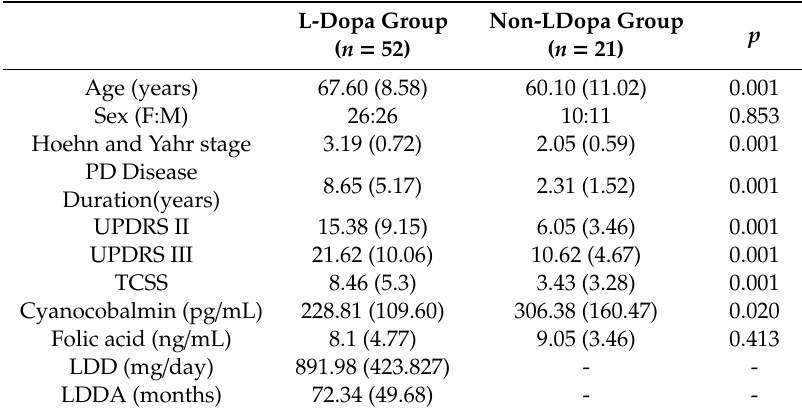
Table 1. Demographic, clinical, and biological features of the groups (independent samples t -test / Chi-square test). LDD, L-Dopa Daily Dose; LDDA, L-Dopa Duration of administration. Results are represented as mean (SD). F, Female; M, Male.